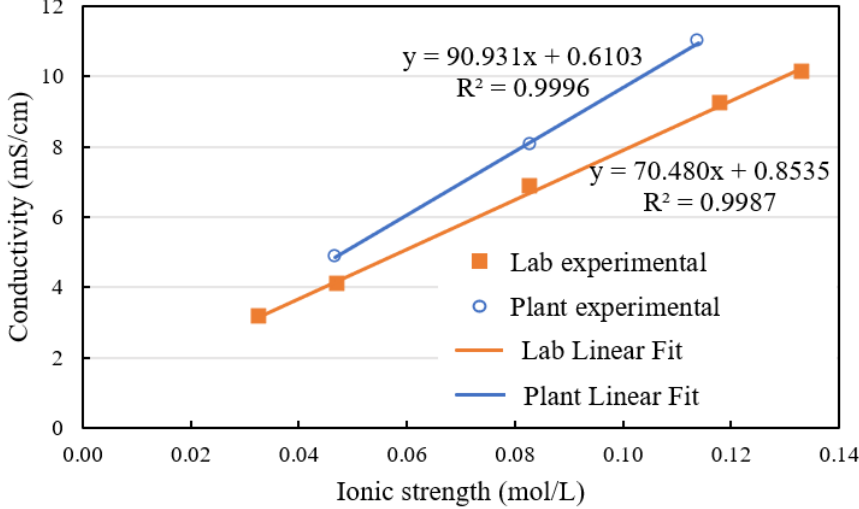
Figure 2. Comparison of lab and plant process water conductivity.